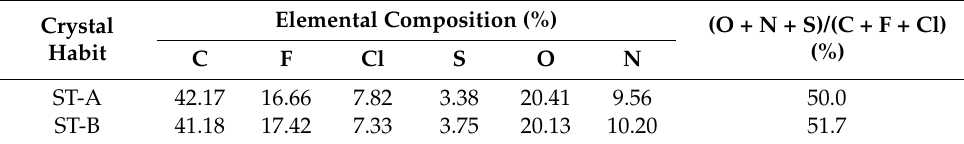
Table 1. Percentage elemental composition on the surface of ST-A and ST-B.